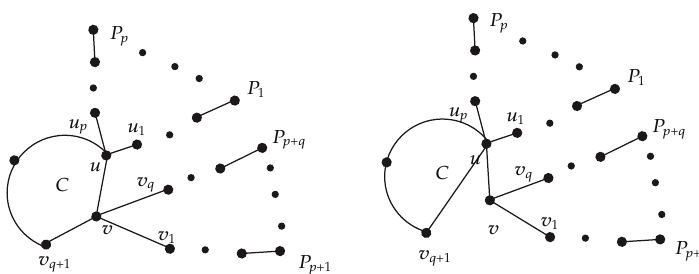
Figure 2: Example of π 2